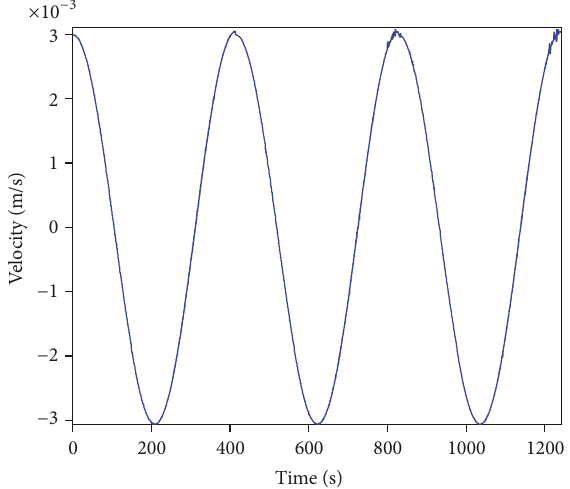
Figure 10: Velocity time-history curve of the damper piston pod.